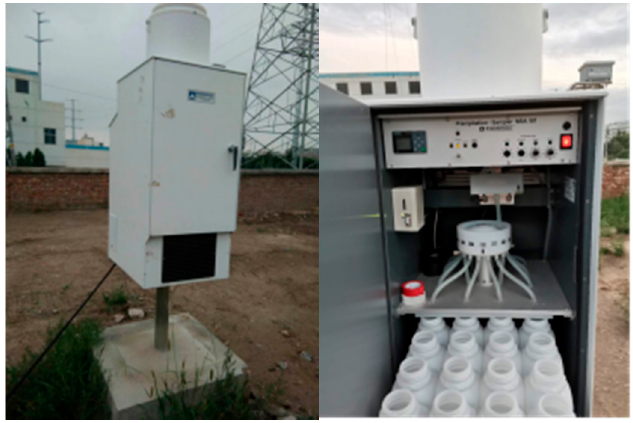
Figure 2. Photograph of the sequential automated precipitation collector.